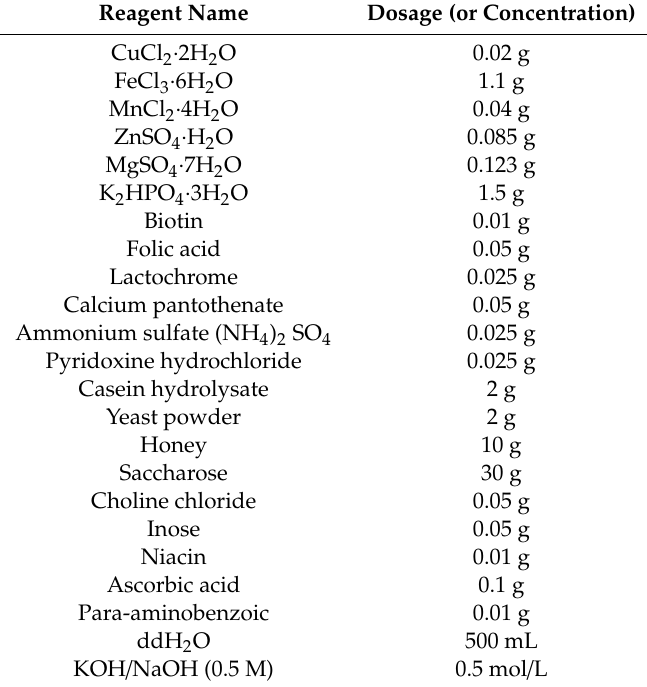
Table 1. Formula of the artificial diet for the spotted alfalfa